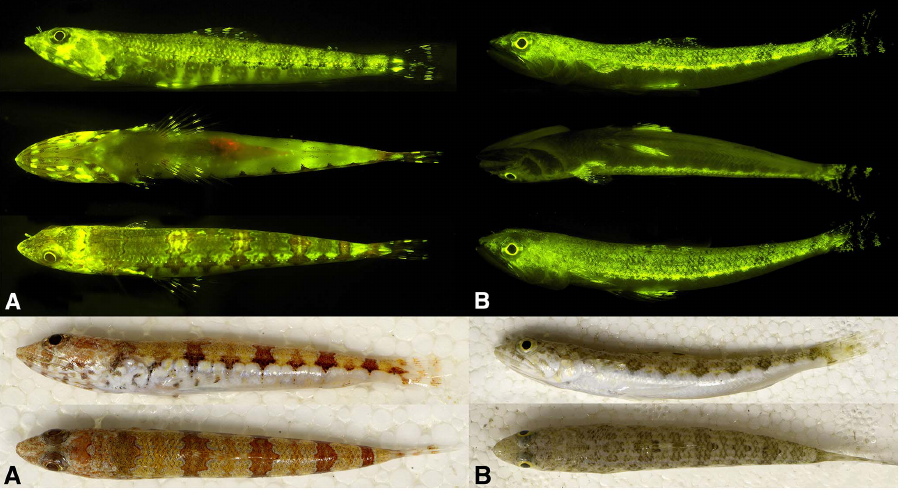
Figure 3. Top panel: Interspecific variation in fluorescent emission pattern (from top: lateral, ventral, and dorsal views) in two congeneric and sympatric members of the lizardfish genus Synodus . A, S. synodus . B, S. saurus . Bottom panel: Interspecific variation in coloration and pigmentation pattern under white light (top: lateral; bottom: dorsal) in same two congeneric and sympatric members of the lizardfish genus Synodus . A, S. synodus . B, S. saurus .